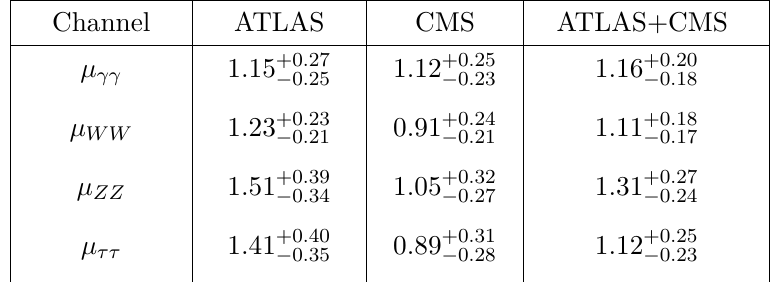
Figure 5 . Exclusion region of m H 0 versus | sin θ | for v σ =1 TeV (top left panel), v σ = 0 . 5 TeV (top right panel) and v = 0 . 1 TeV (bottom panel). The blue regions are excluded by LEP results. The σ magenta regions correspond to an invisible BR greater than 19% and are therefore excluded by LHC [42].